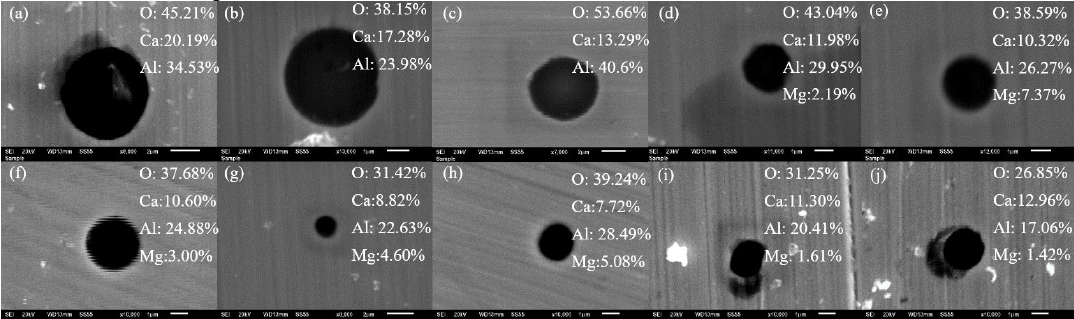
Figure 12. Morphology of inclusions in electroslag ingots prepared with slag containing 2% or 6% Al 2 O 3 . ( a – c ): Ca-Al-O inclusions; ( d – j ): Ca-Al-Mg-O inclusions.